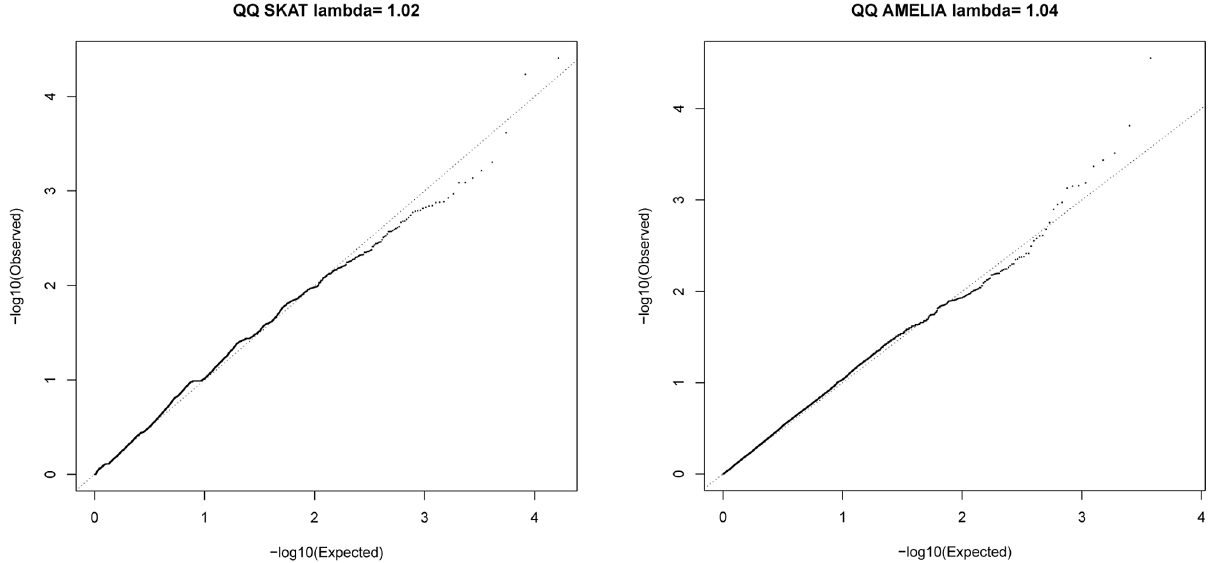
Figure 4. QQ plots for SKAT and AMELIA analyses using primary controls.